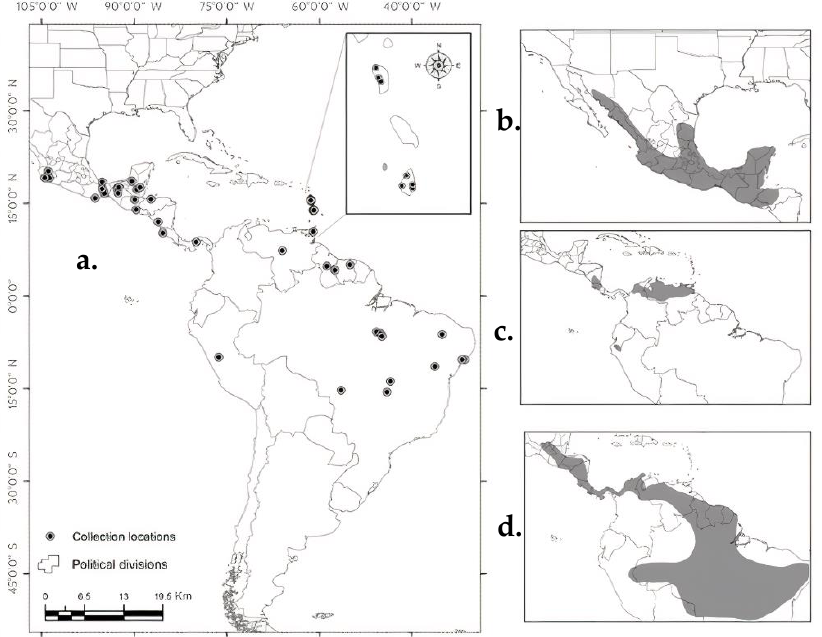
Figure 1. ( a ). Study localities and distribution of the three Pteronotus species: ( b ). P. fulvus , ( c ). P. davyi and ( d ). P. gymnonotus following [31]. Based on an intensive sampling conducted in allopatric and sympatric localities of P. fulvus and P. gymnonotus , this study pursued the following objectives: (1) evaluate whether forearm length and latitude are correlated; (2) discern the taxonomic composition of the subgenus Pteronotus ; (3) determine whether hybridization between P. fulvus and P. gymnonotus has occurred and (4) confirm whether the intermediate-sized morphotypes correspond to hybrids between P. fulvus and P. gymnonotus